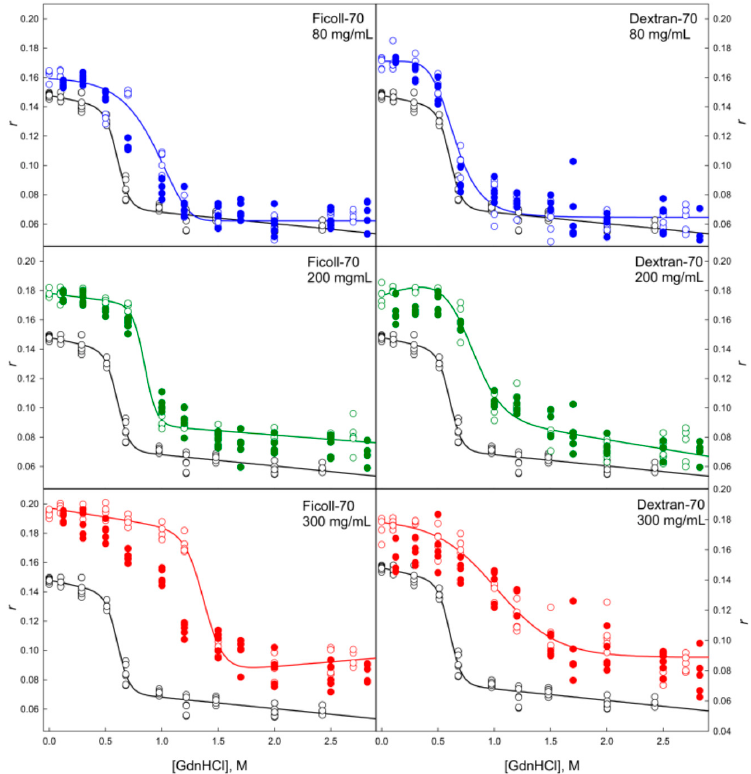
Figure 9. Unfolding/refolding transitions of GGBP in the presence of different concentrations of Ficoll-70 and Dextran-70 recorded as the dependence of the anisotropy of intrinsic fluorescence on GdnHCl concentration. The excitation wavelength was 297 nm, the emission wavelength was 365 nm. Other designations as in Figure 4.